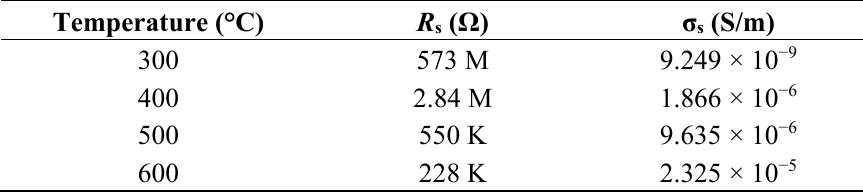
Table 1. Comparison of impedance parameters’ at different